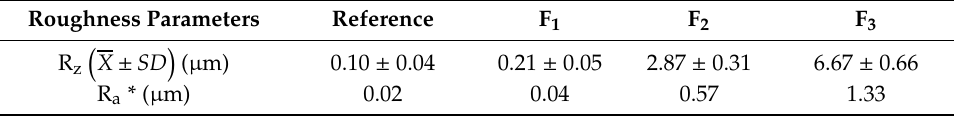
Table 2. Roughness parameters describing surface topography of micro-patterned PLLA. Roughness Parameters